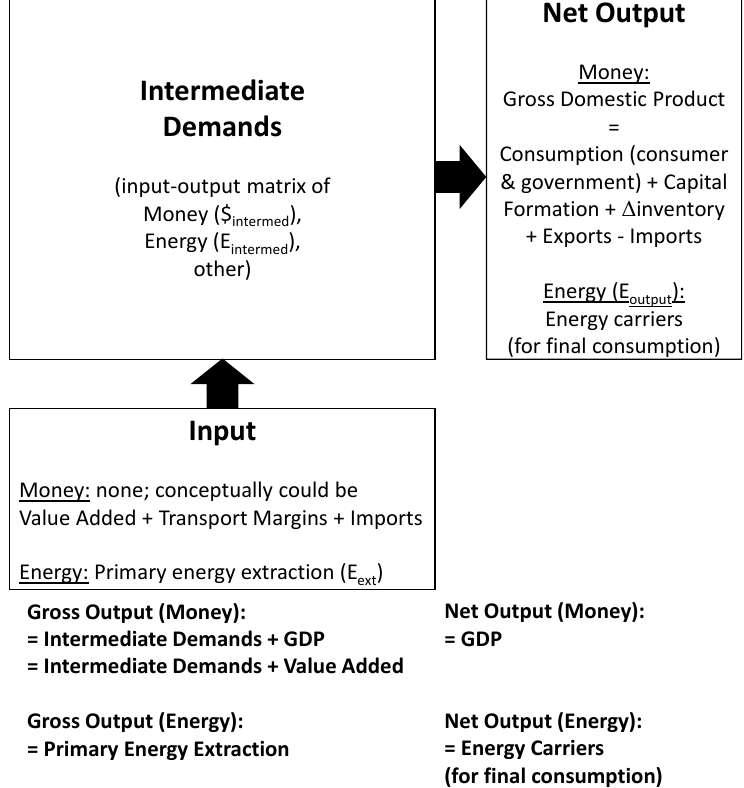
Figure 1. Input-output analysis graphic comparing terms for economic and net energy analysis. The graphic is for conceptual purposes to understand the relations between energy analysis methods and monetary I-O